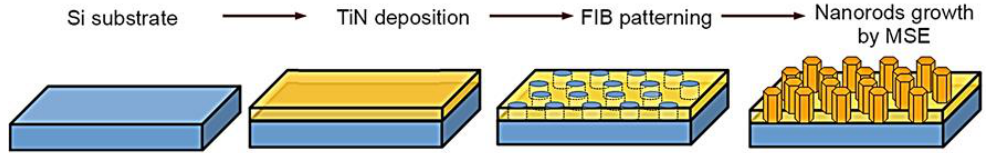
Figure 1. Process description of the selective-area growth (SAG) of GaN nanorods (NRs) on focused ion beam lithography (FIBL) patterned substrates.